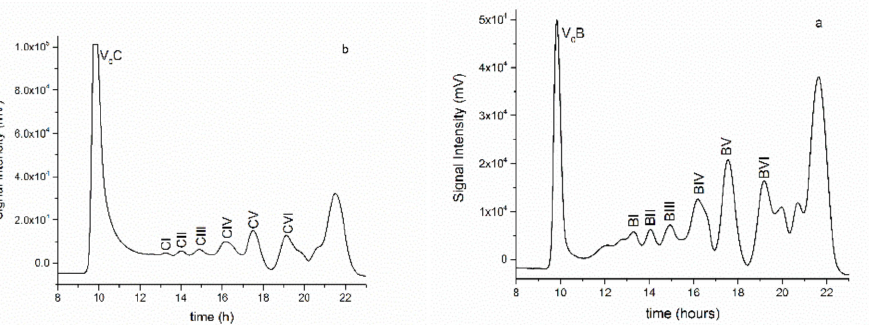
Figure 3. Chromatograms of the hydrolysate from PLS-B ( a ) and PLS-C ( b ) Vo indicates the excluded volumes; peaks were labeled BI–BVI and CI–CVI in order of increasing elution